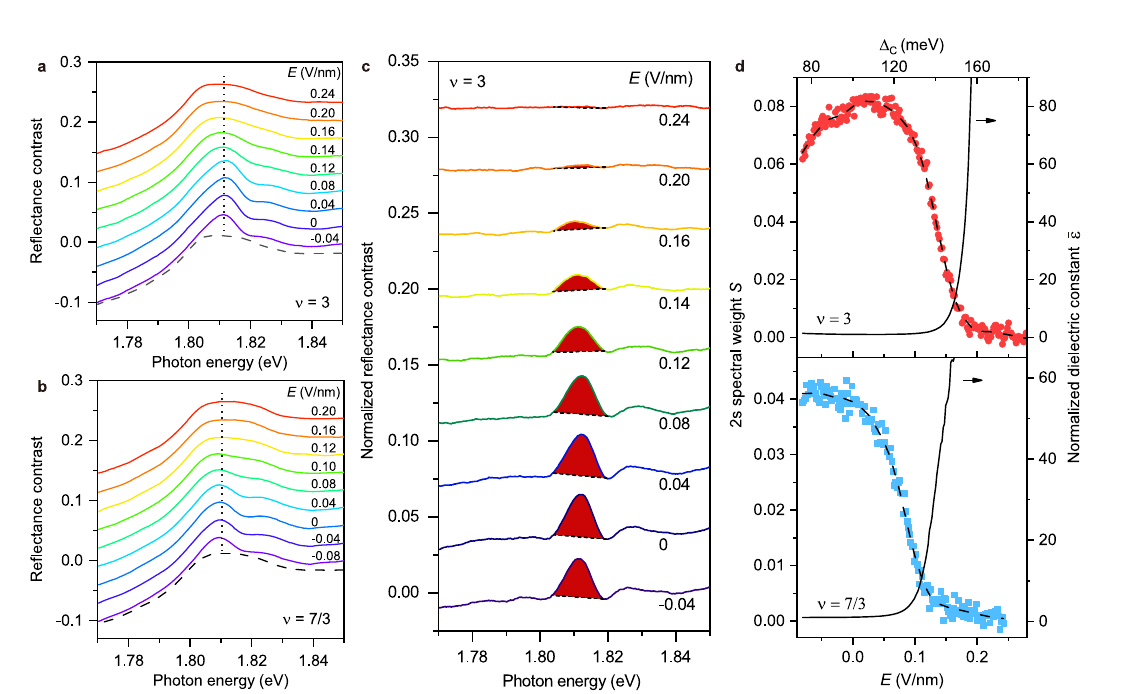
0.06V/nm ( c ), 0.12V/nm ( d ) and 0.2V/nm ( e ). The incompressible states at E = − 0.02V/nm manifest enhanced re fl ectance contrast and are labeled by the dashed black lines. They gradually disappear as electric fi eld increases.